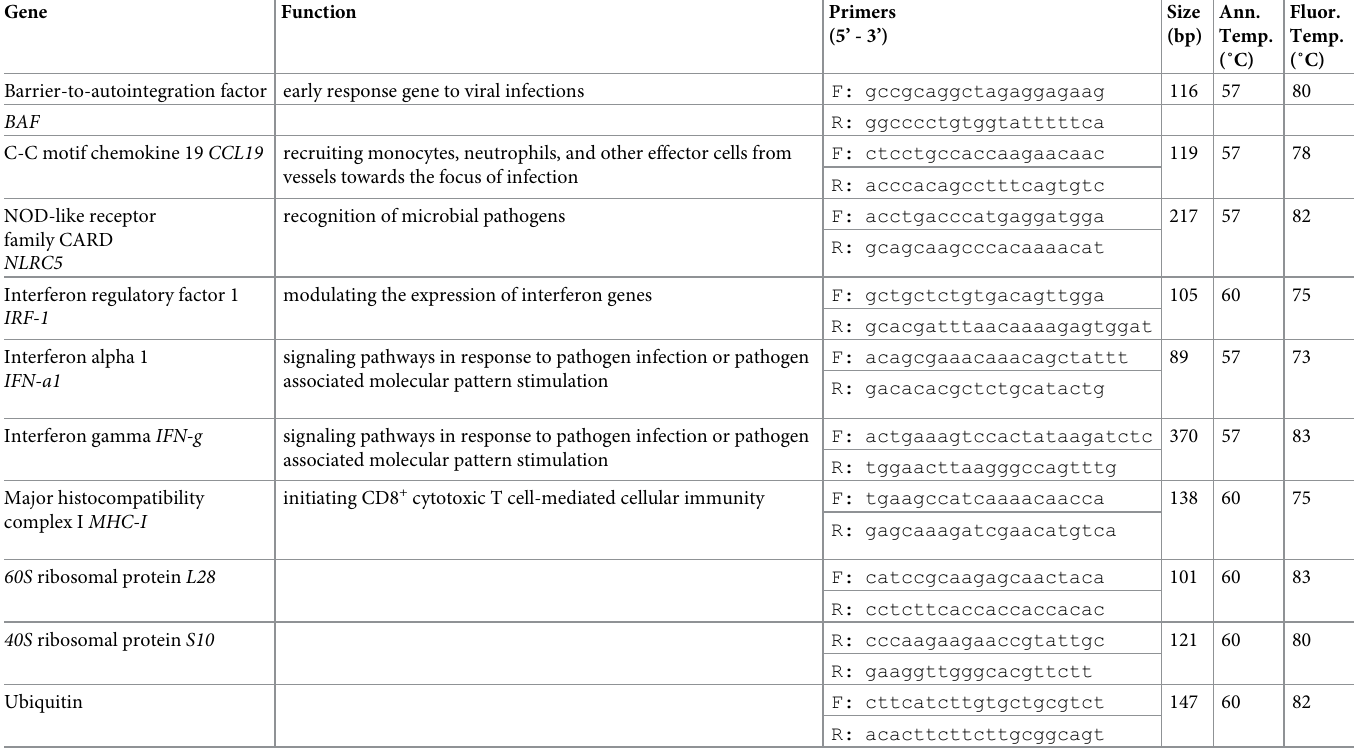
Table 2. The seven selected genes associated with immune response in fish species (according to [21, 22, 23, and 24]) and the three reference genes: Function of immune relevant genes, designed RT-qPCR primers, product size (bp), annealing temperature (Ann. Temp.) and temperature for fluorescence acquisition (Fluor.